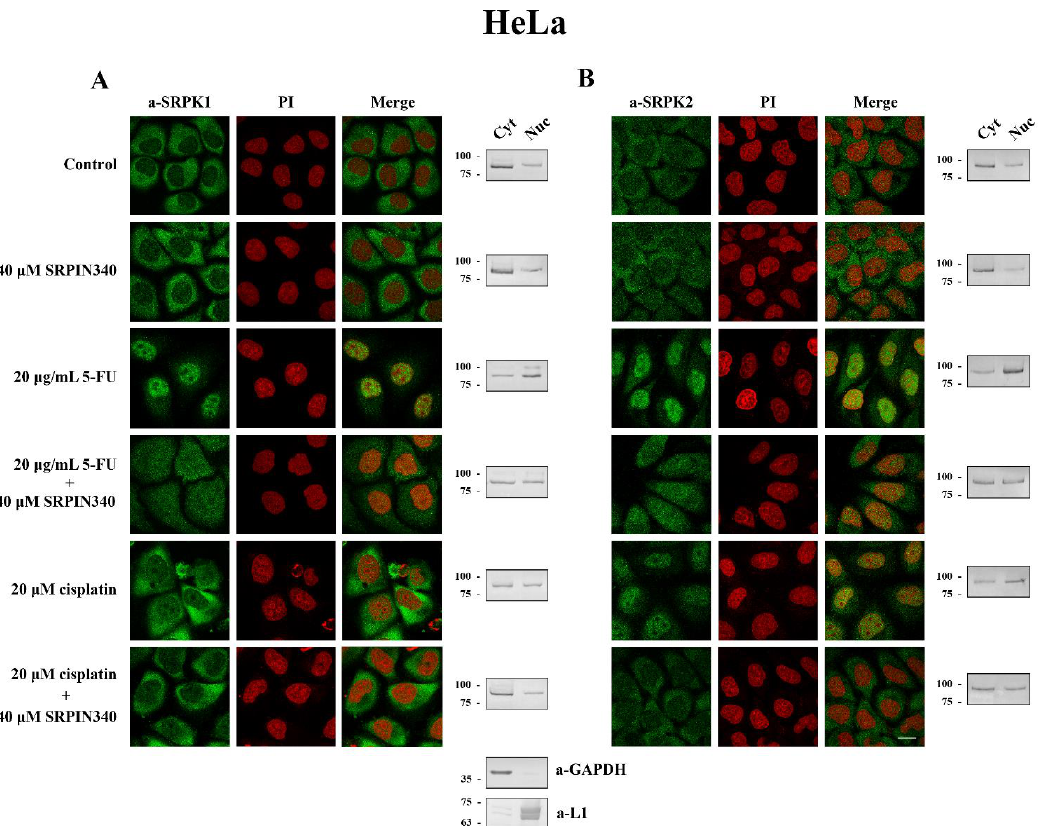
Figure 5. SRPIN340 prevented the nuclear translocation of SRPK1 and SRPK2 in 5-FU- and cisplatin-treated HeLa cells. Fluorescent patterns of SRPK1 (( A ), left panel ) and SRPK2 (( B ), left panel ) in HeLa cells treated with 40 µM SRPIN340 for 48 h, 20 µg/mL 5-FU for 48 h, 20 µg/mL 5-FU plus 40 µM SRPIN340 for 48 h, 20 µM cisplatin for 24 h, or 20 µM cisplatin plus 40 µM SRPIN340 for 24 h. SRPK1 and SRPK2 were detected using the respective anti-SRPK1 and anti-SRPK2 mono- clonal antibodies, while the nuclei were stained with PI. Scale bar: 10 µM. A cell fractionation method (described in the Materials and Methods section) was also employed to analyze the subcellular distribution of SRPK1 (( A ), right panel ) and SRPK2 (( B ), right panel ). Cytoplasmic (Cyt) and nuclear (Nuc) extracts were subjected to Western blotting using the re- spective anti-SRPK1 and anti-SRPK2 monoclonal antibodies. The distribution of GAPDH (a-GAPDH) and lamins (a-L1) was used as a marker to assess the fractionation efficiency.